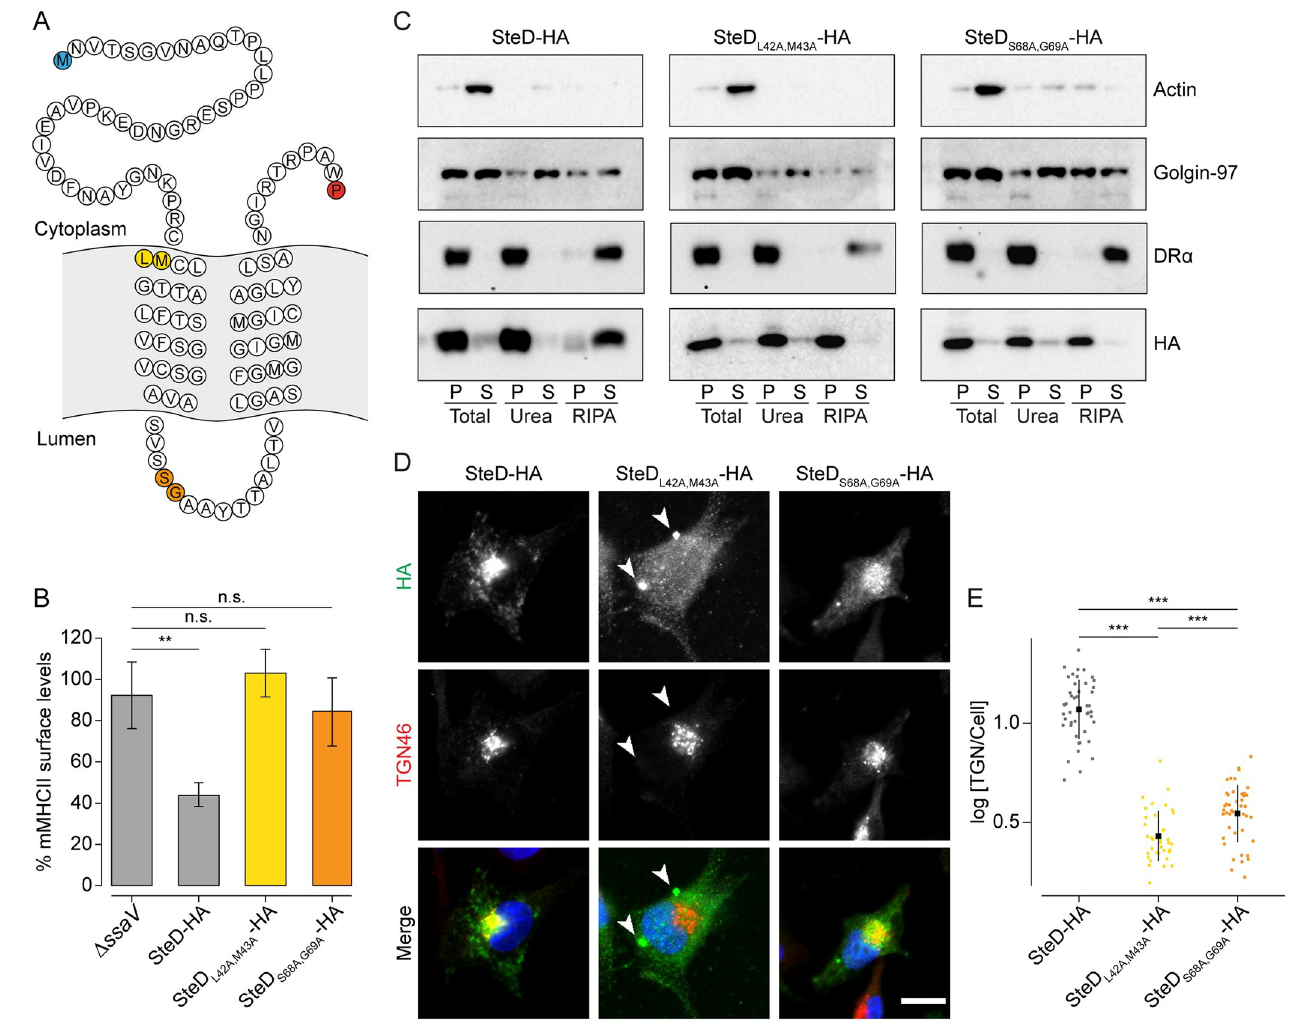
Fig 3. Membrane integration following translocation. (A) Amino acid sequence of SteD showing predicted transmembrane domains. The N- and C-terminal residues are highlighted in blue and red respectively. The residues substituted to alanines in SteD L42A,M43A and SteD S68A,G69A mutants are highlighted in yellow and orange respectively. (B) mMHCII surface levels of Mel JuSo cells infected with Δ steD Salmonella carrying a plasmid expressing SteD-HA (wt or mutants) or SPI-2 null Δ ssaV Salmonella and treated with MG132. Cells were analysed by flow cytometry and amounts of surface mMHCII in HA-positive cells are expressed as a percentage of HA-negative cells in the same sample. Mean of three independent experiments done in duplicate ± SD. Data were analysed by one- way ANOVA followed by Dunnett’s multiple comparison test, �� p < 0.01, n.s.–not significant. (C) Protein immunoblots of membrane fractionation samples from Mel Juso cells infected with Δ steD Salmonella strains carrying a plasmid expressing SteD-HA (wt or mutants) and treated with MG132. Samples were taken from the pellet (P) and supernatant (S) of the total sample, after urea wash and after RIPA wash. (D) Representative confocal immunofluorescence microscopy images of Mel Juso cells infected with Δ steD Salmonella strains carrying a plasmid expressing SteD-HA (wt or mutants) and treated with MG132. Cells were fixed and processed for immunofluorescence microscopy by labelling for HA (green), the TGN (TGN46, red), and DNA (DAPI, blue). Arrowheads indicate cellular aggregates. Scale bar– 10 μ m. (E) Quantification of HA signal at the TGN of cells represented in Fig 3D. The fluorescence intensity of the HA signal at the TGN was measured in relation to total cellular fluorescence. Data are representative of three independent experiments. Each dot represents the value for one cell. Mean ± SD. The log 10 fold change of the data were analysed by one-way ANOVA followed by Dunnett’s multiple comparison test, ��� p < 0.001.